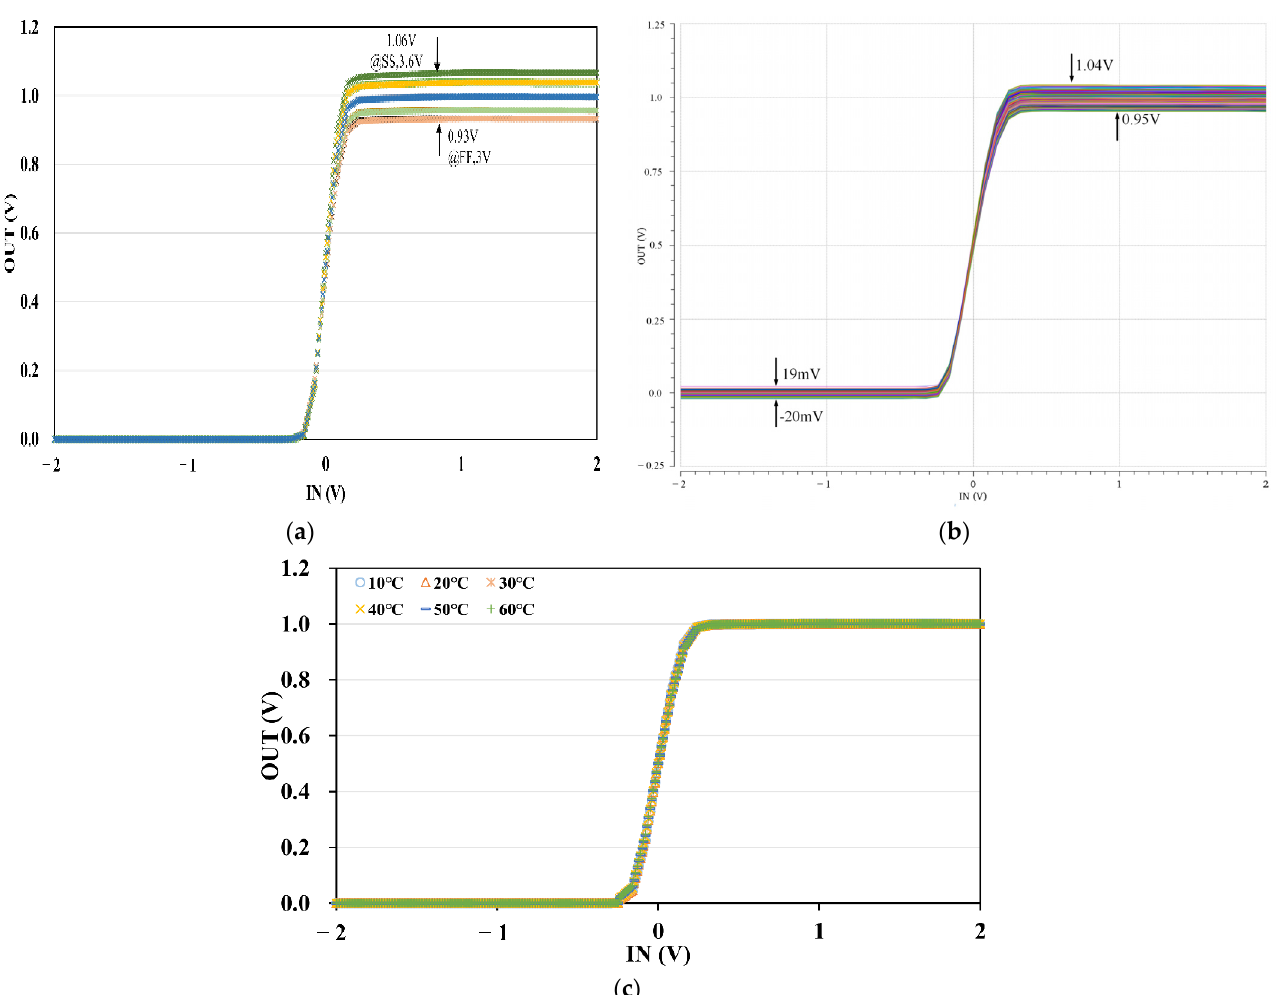
Figure 8. ( a ) DC scanning of the proposed circuit for various process corners and supply voltages. ( b ) The output of the simulations for changing temperatures with an increment of 10 °C. ( c ) The Monte Carlo simulation of the output.